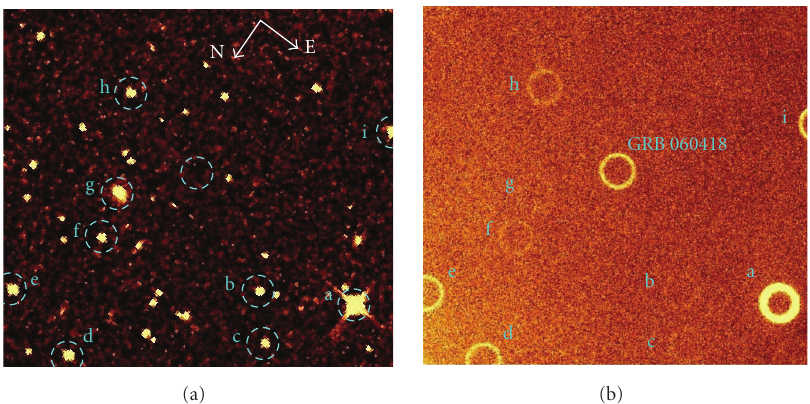
Figure 9: (a) DSS image of the field before the occurrence of GRB 060418. (b) RINGO image showing GRB 060418 and other field sources as rings (from